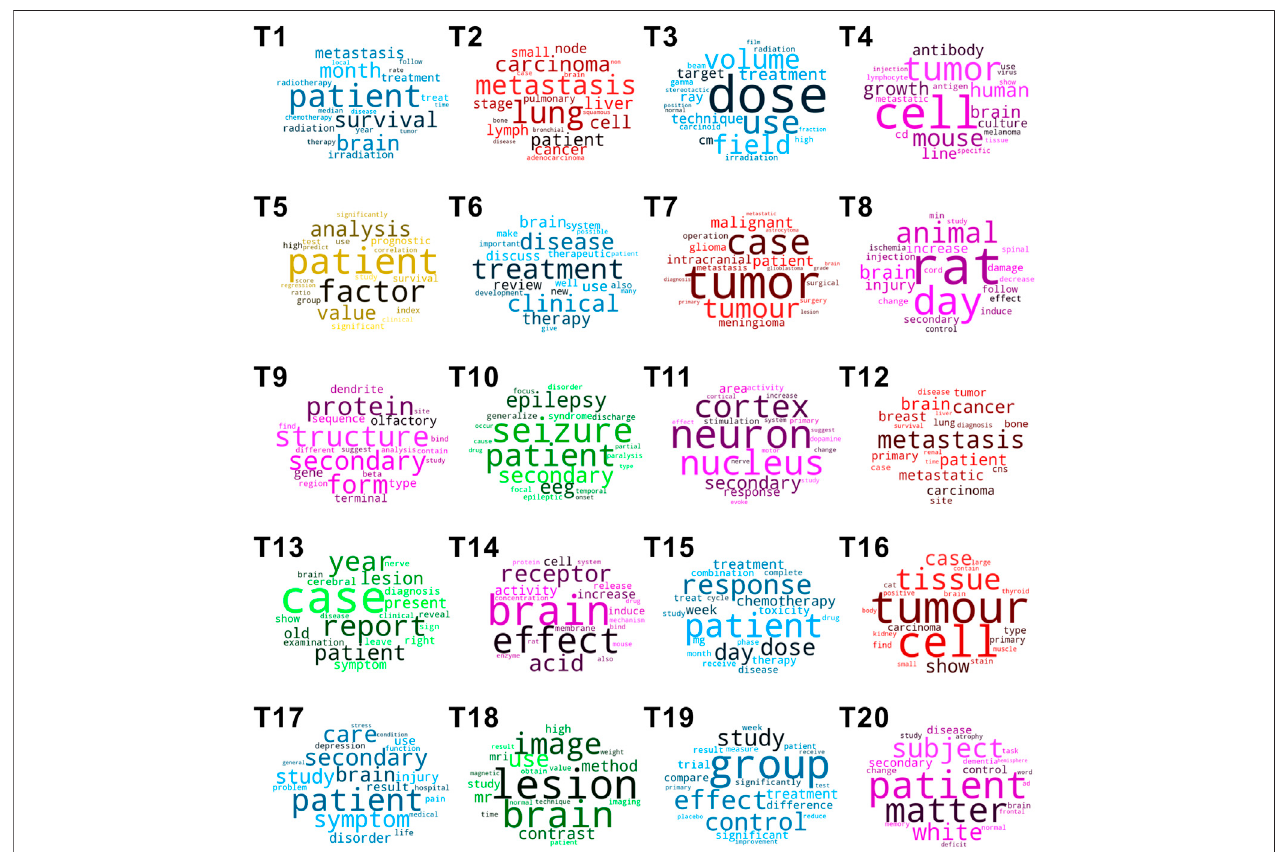
FIGURE 4 | Term frequency clouds of 20 topics on brain metastases. Topics in blue: topics related to treatment (T1, T3, T6, T15, T17, and T19). Topics in red: topics related to tumour relationship (T2, T7, T12, and T16). Topics in purple: topics related to histopathology (T4, T8, T9, T11, T14, and T20). Topics in mocha: topic related to prognosis (T5). Topics in green: topics related to diagnosis (T10, T13, and